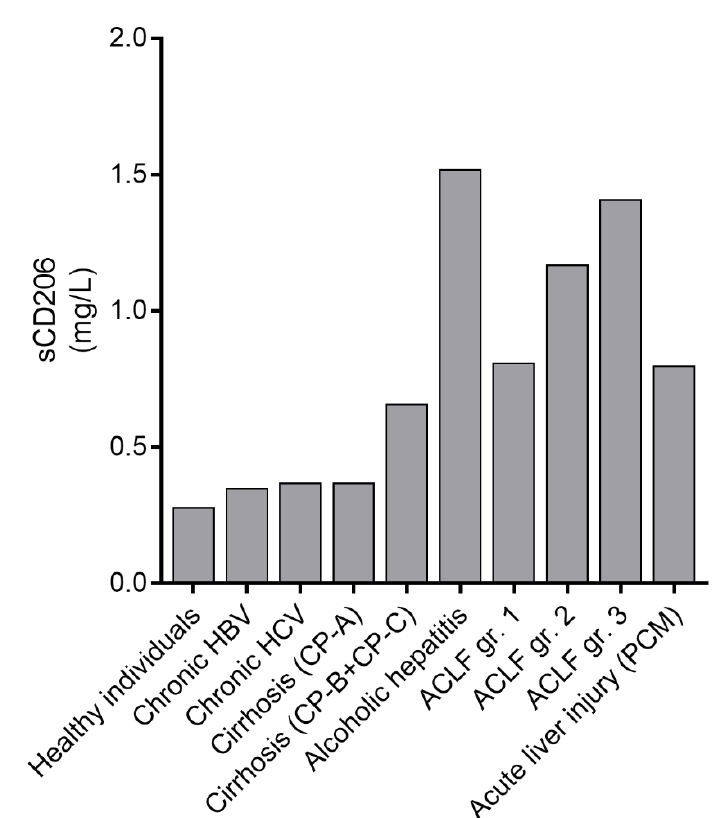
Figure 5. Median concentrations of sCD206 from selected studies covering healthy individuals and patients with liver diseases of di ff erent etiology and increasing disease severity [6,75,78–80,91,99]. HBV, hepatitis B virus; HCV, hepatitis C virus; CPA, Child-Pugh-score A; CPB, Child-Pugh-score B; CPC, Child-Pugh-score C; PCM, paracetamol (acetaminophen); ACLF, Acute-on-Chronic Liver Failure; gr., grade.